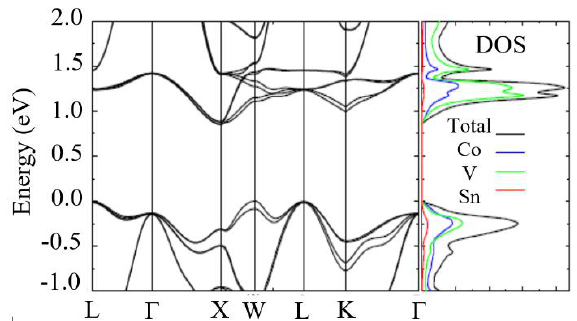
Figure 2. Calculated electronic band structure and density of states (DOS) of the CoVSn alloy. Reproduced from [38], Elsevier: 2017.